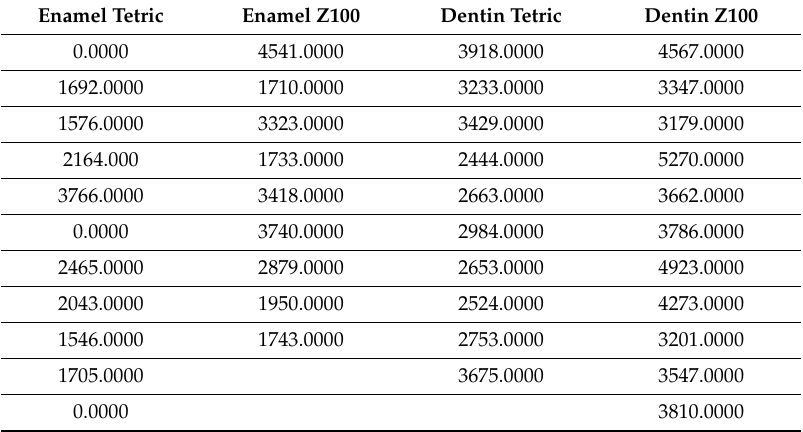
Table 1. Measurements of carious lesion areas in squared micrometers ( µ m 2 ).